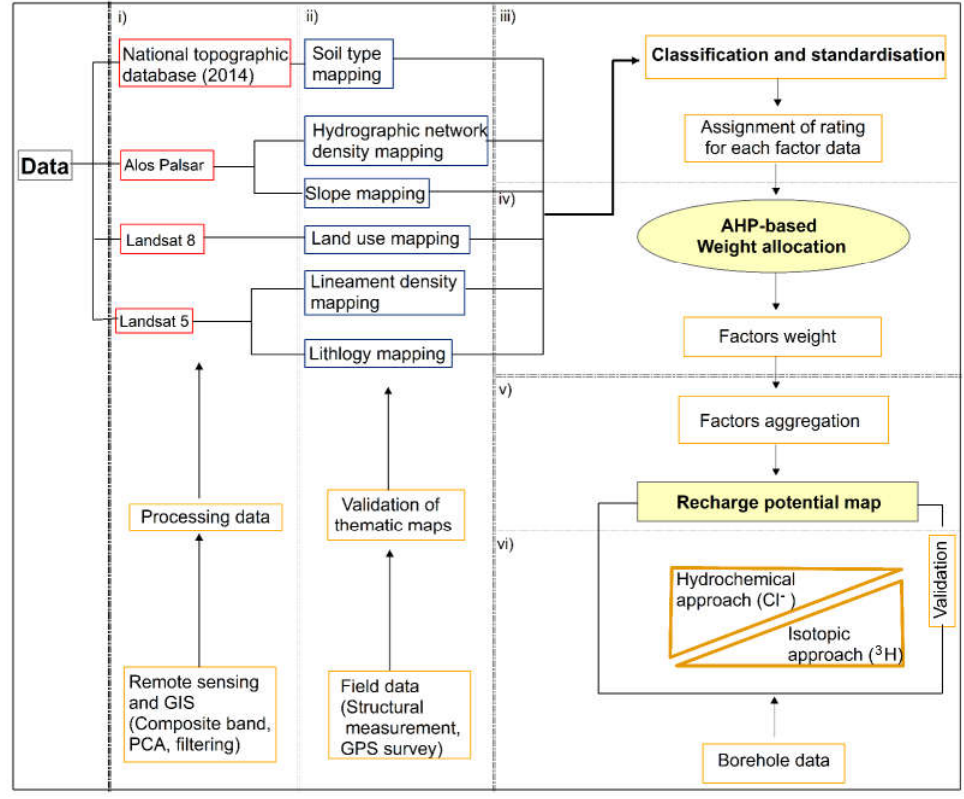
Figure 5. Conceptual diagram of the approach.